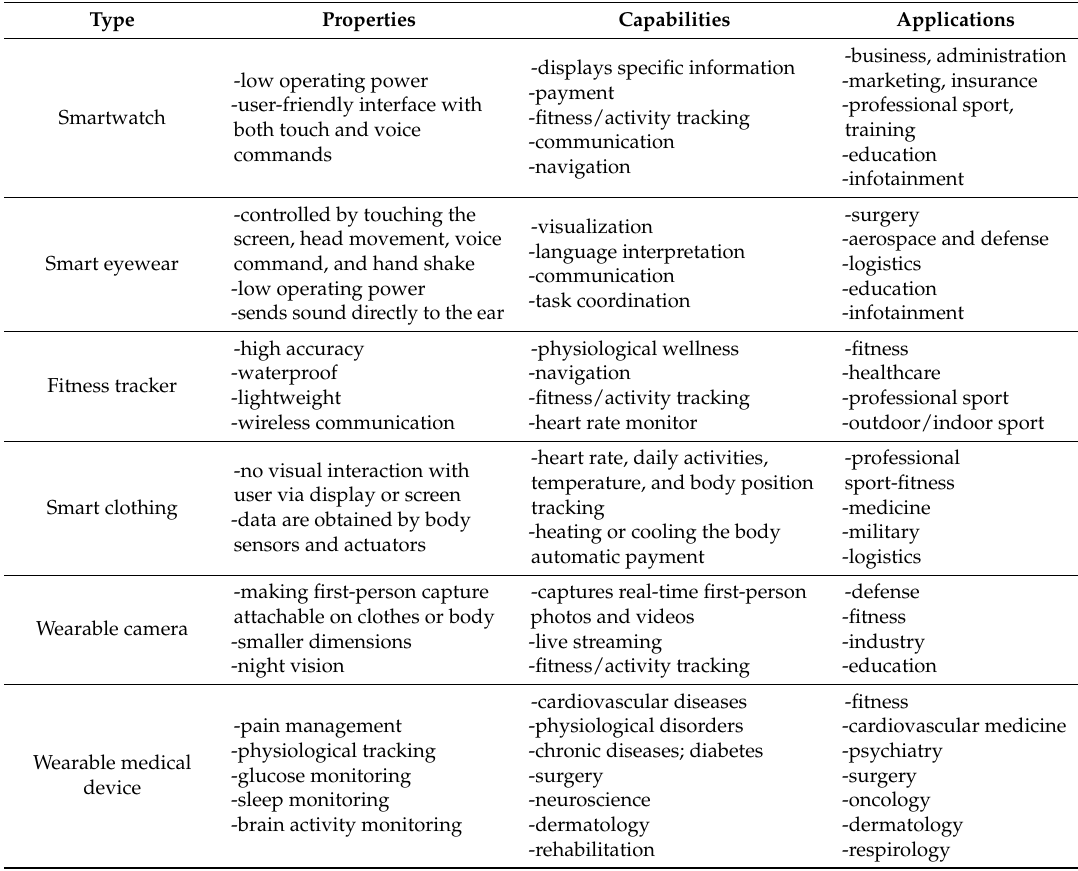
Table 1. Classification of wearable technologies, along with their properties, capabilities, and sectors of